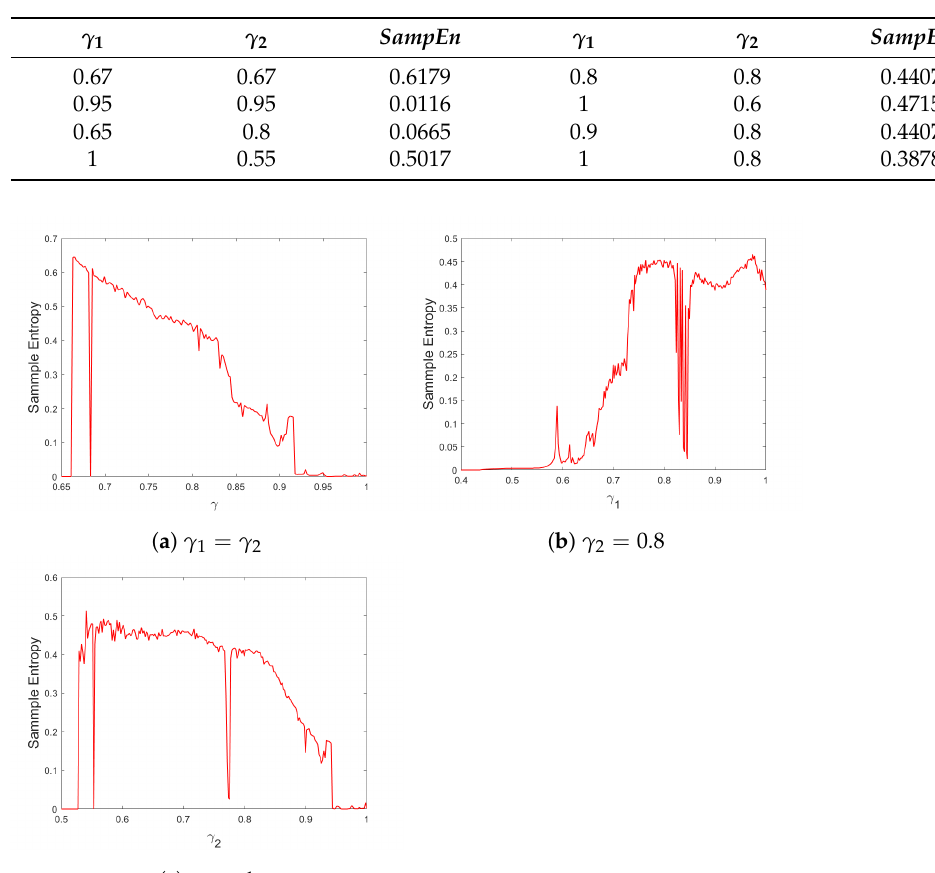
Table 1. The sample entropy results of the fractional predator–prey discrete system.